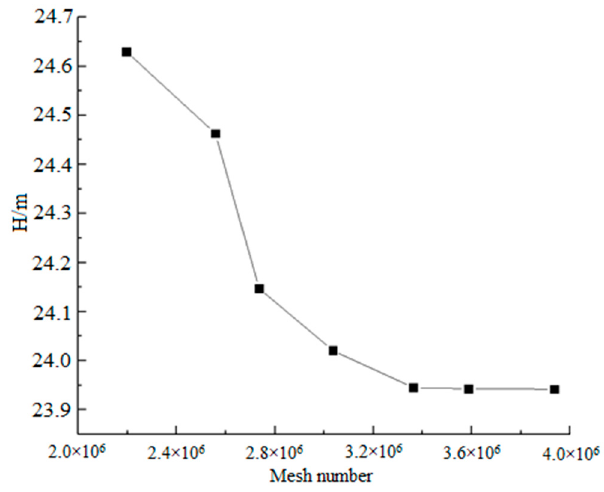
Figure 3. The validation of mesh independence.